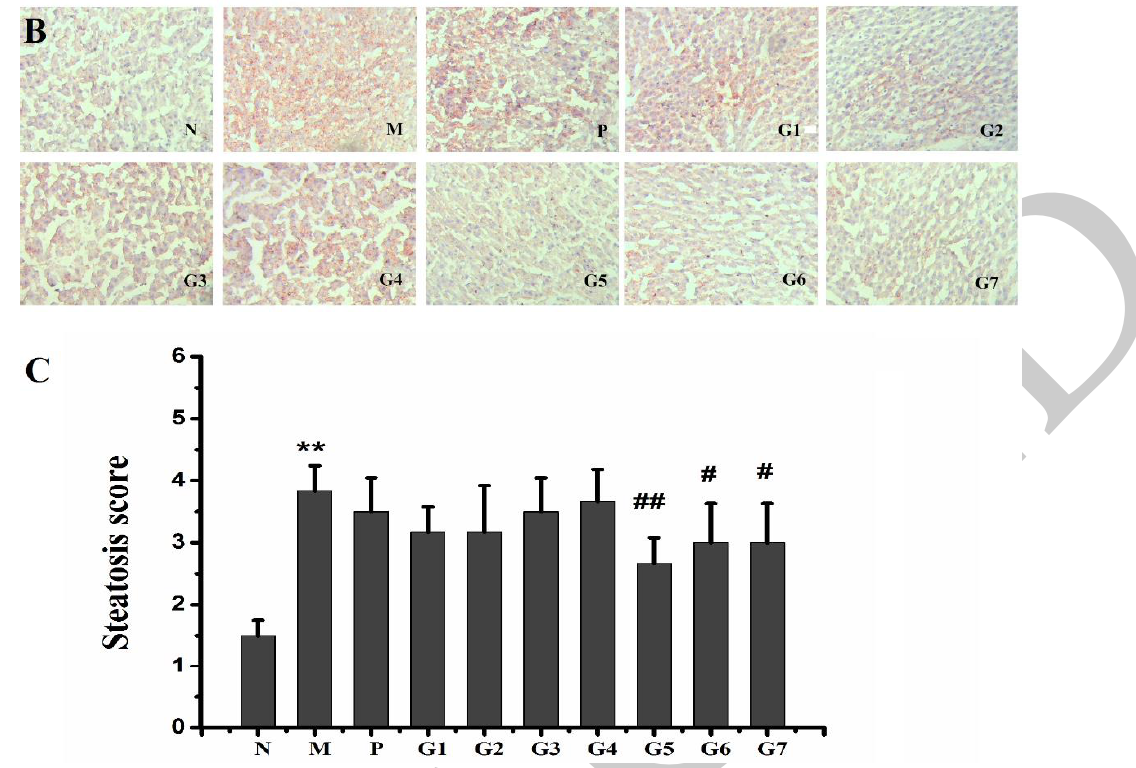
Figure 5. Effect of GA on hepatic histology determined by H&E staining ( A ) and Oil red O staining (magnification 100 × ) ( B ); Steatosis score ( C ) was graded on a scale of 0 (<5%), 1 (5–33%), 2 (34–66%), and 3 (>66%). N: normal group, M: model group, P: silybin positive group, G1: 18α-GA:18β-GA = 10:0,